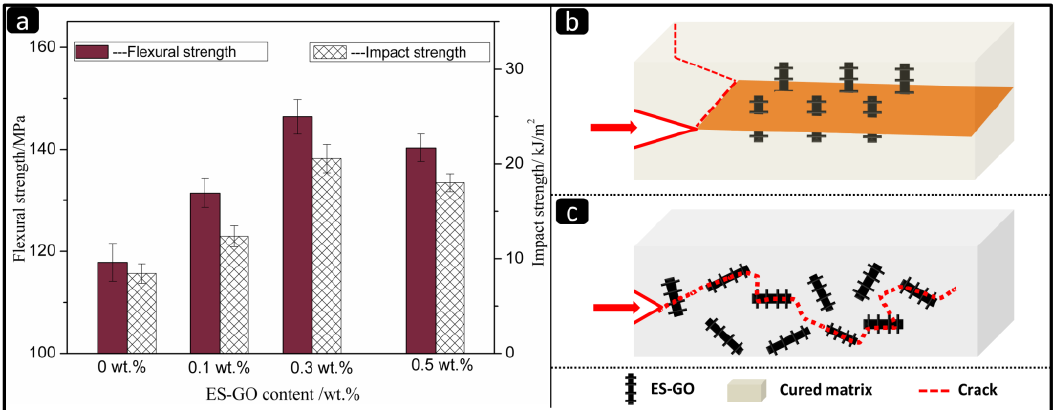
Figure 5. ( a ) Mechanical properties of the cured resins with different content of ES-GO; ( b ) mechanism of crack pining; ( c ) mechanism of crack